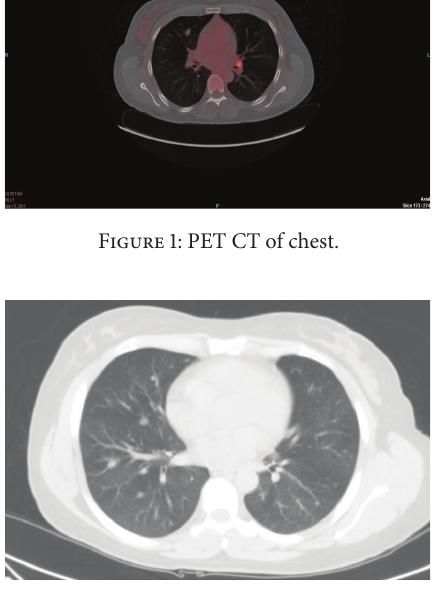
Figure 2: CT chest. Multiple subcentimeter bilateral lung